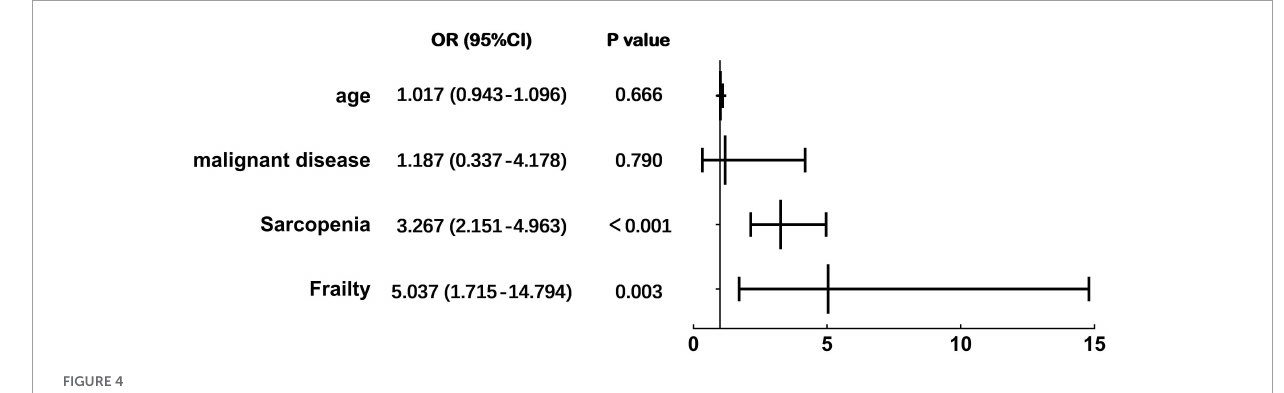
FIGURE4 Multivariate regression analysis for